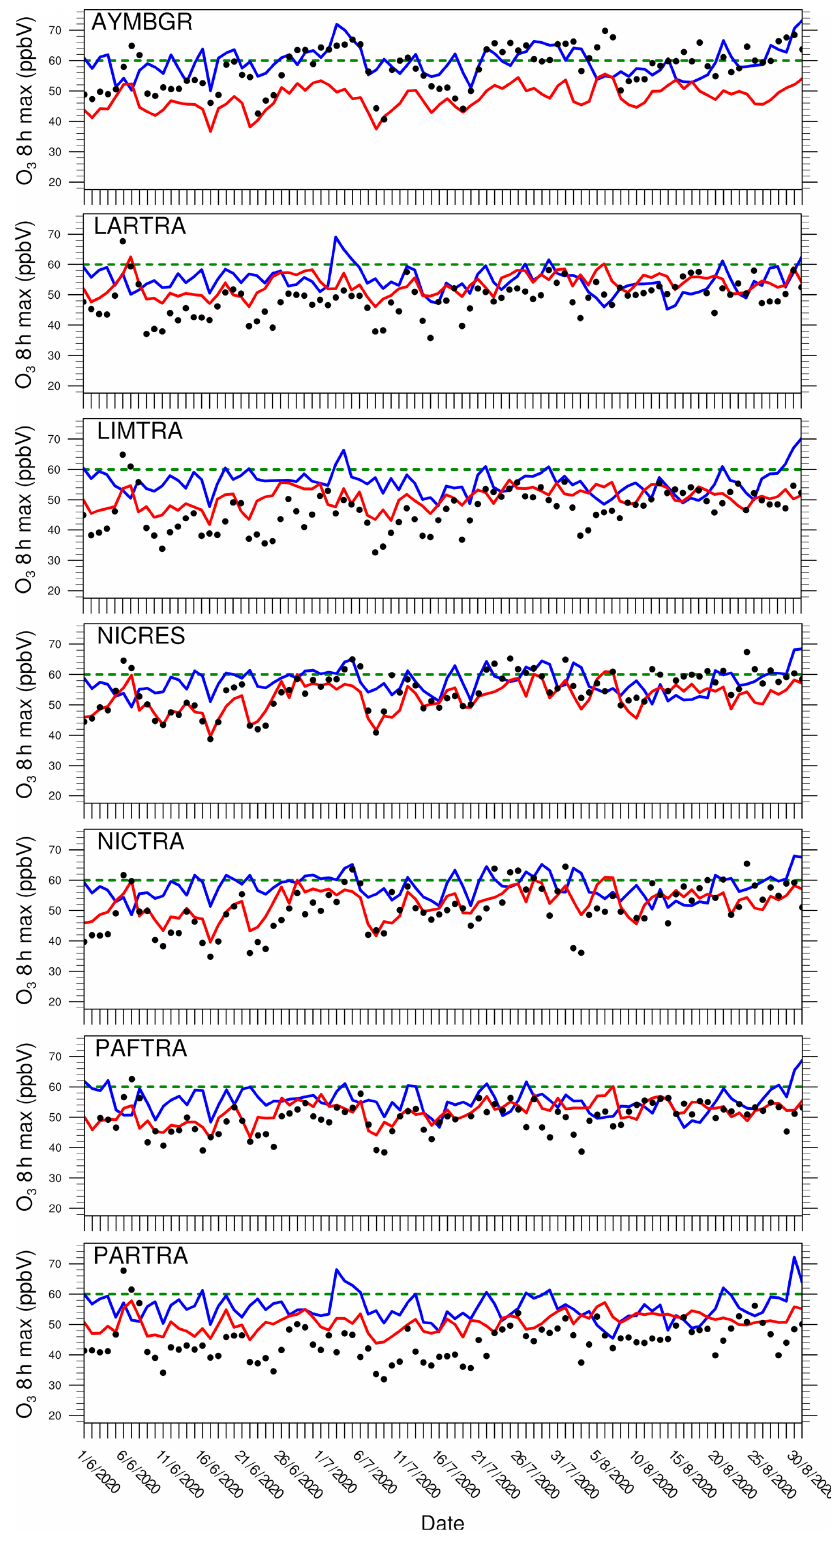
Figure 7. O 3 daily maximum 8h average at the Ayia Marina background station and the urban stations in observation data (black dots), the WRF-Chem (blue lines) and the CAMS (red lines) forecasts during summer. The green line indicates the limit value set by the European air quality directives (EU,